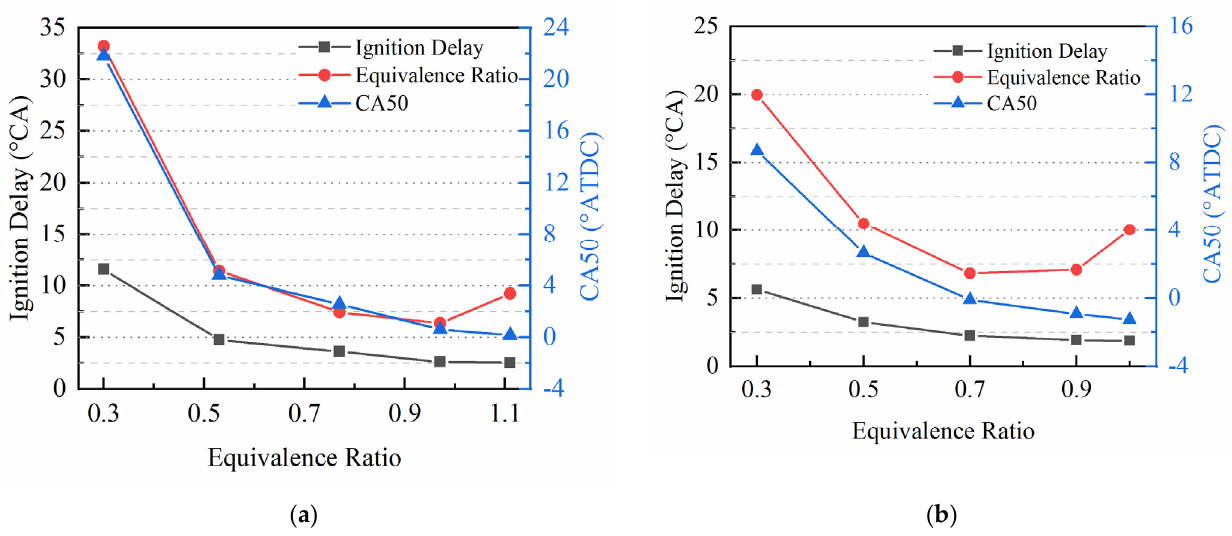
Figure 2. Ignition delay, combustion duration, and CA50 at different equivalence ratios [48]. ( a ) CR = 12. ( b ) CR = 15. Table 3. Working condition parameters of different equivalence ratios